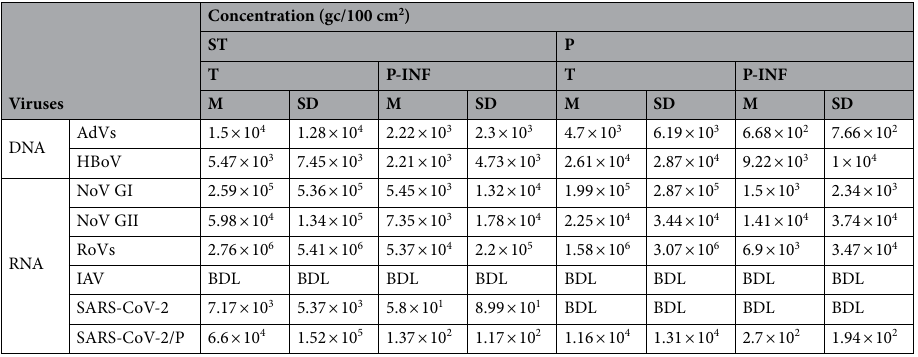
Table 6. The concentrations of DNA and RNA viruses (gc/100 cm 2 ) in positive swab samples from steel and plastic surfaces. ST steel, P plastic, T total concentration of viruses, P‑INF concentration of potentially infectious viruses, M arithmetic mean value, SD standard deviation, BDL below detection limit, AdVs adenoviruses, HBoV human bocavirus, NoV GI Norwalk virus genogroup I, NoV GII Norwalk virus genogroup II, RoVs rotaviruses, IAV influenza A virus, SARS‑CoV‑2 severe acute respiratory syndrome coronavirus 2, SARS‑CoV‑2/P presumptive SARS-CoV-2 positive/other coronaviruses